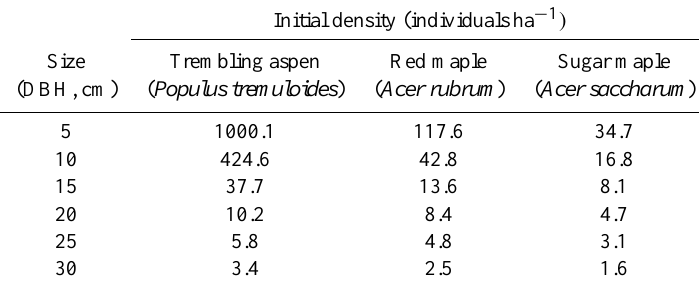
Table C4. Size distribution of initial trees in the succession